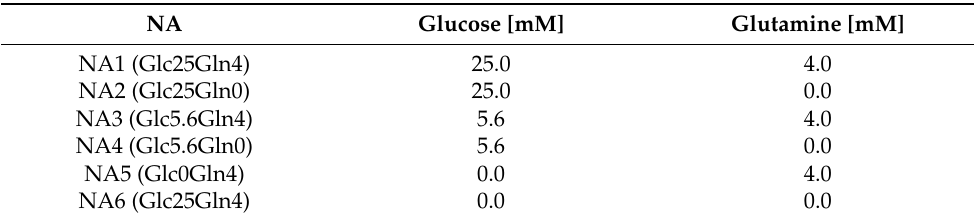
Table 1. NA data used in experiments in terms of their varying glucose and glutamine concentrations. The NA further contained all components like in standard DMEM medium. The concentrations were verified via HPLC